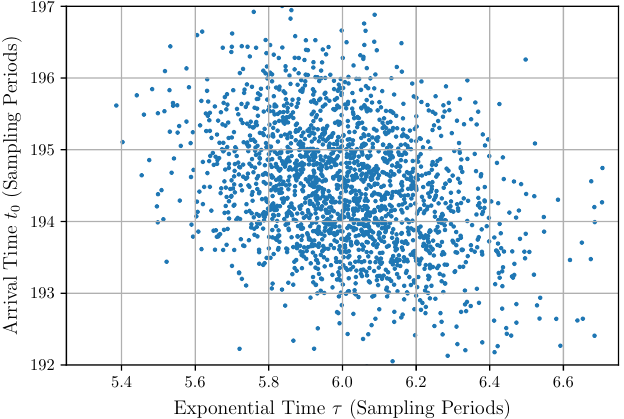
Figure 13. Scatter plot of the arrival time vs. the exponential time. Even though we considered that the background slope is constant, a negative trend can be observed between offsets and slopes in Figure 14. This effect is also reflected in the value of the correlation distance between the offset and slope vectors. This value indicates that the gain of the CSA is not constant and reveals a non-linear behavior which in turn determines an error in the arrival-time detection.